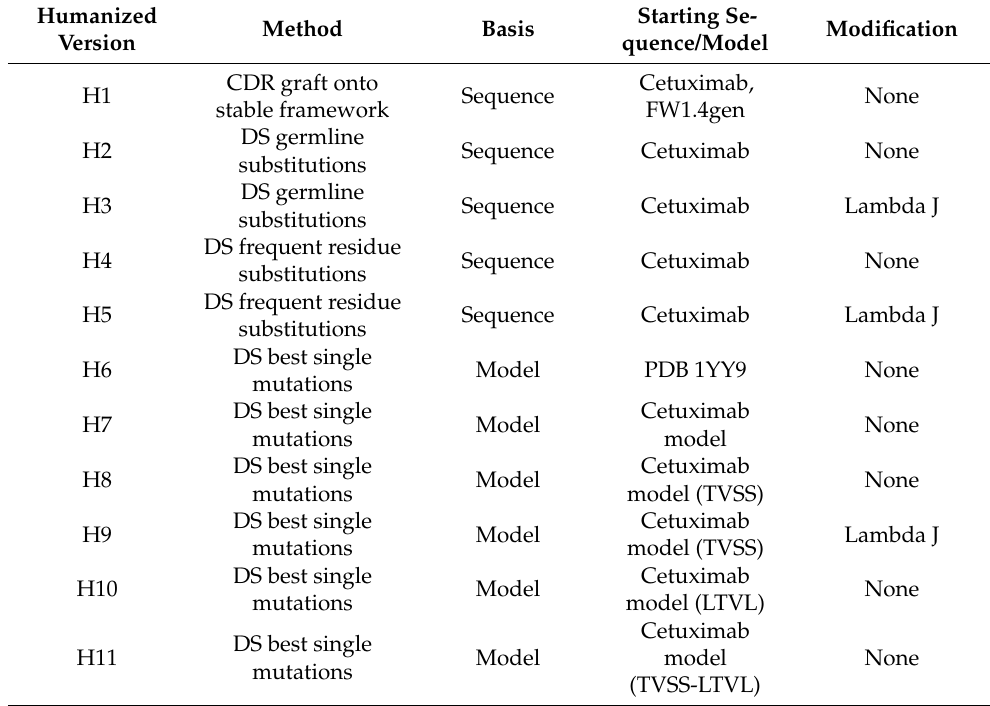
Table 1. Methods for generating humanized cetuximab